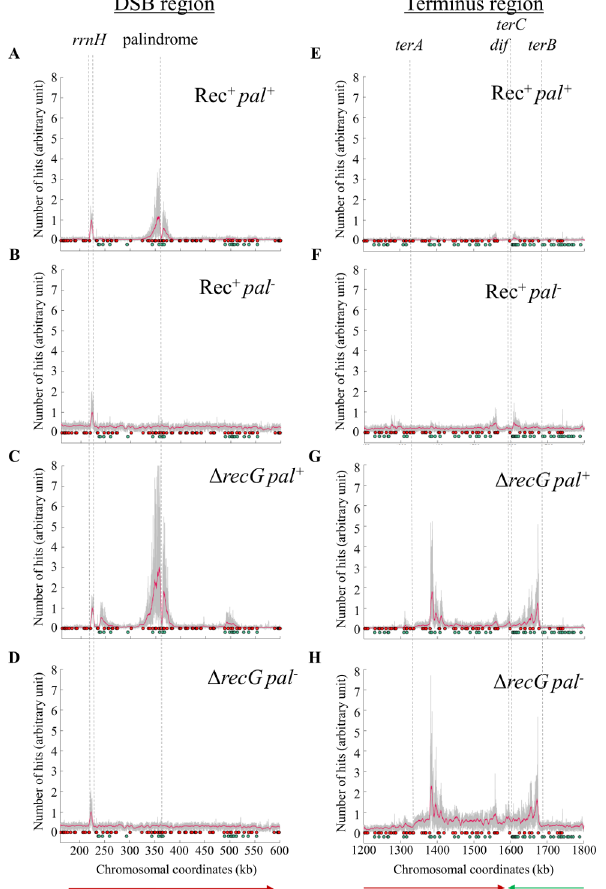
Fig 3. Relative RecA ChIP-seq reads in the lacZ DSBR region (A-D) and terminus region (E-H) of the chromosome. The raw data are shown in grey and smoothed data are shown in red. The smoothed data were plotted using a moving average filter with a 4 kb window. Red and green circles indicate Chi sites. Red Chi sites interact with RecBCD enzymes moving from right to left and green Chi sites interact with RecBCD enzymes moving from left to right. The closest Chi sites on either side of the DSB in lacZ were triple Chi arrays at 1.5kb from the palindrome, which have been used previously [9]. The positions of the rrnH operon, the palindrome at which a DSB is induced, termination sites ( terA , terB and terC ) and the site of resolution of chromosome dimers ( dif ) are all indicated. The direction of replication is indicated by green and red arrows for the left and the right replichore, respectively. A. and E. Rec + Pal + ; B. and F. Rec + Pal - ; C. and G. Δ recG Pal + ; D. and H. Δ recG Pal - . Strains used were DL4184 (Rec + Pal + ), DL4201 (Rec + Pal - ), DL4311 ( Δ recG Pal + ), and DL4312 ( Δ recG Pal -